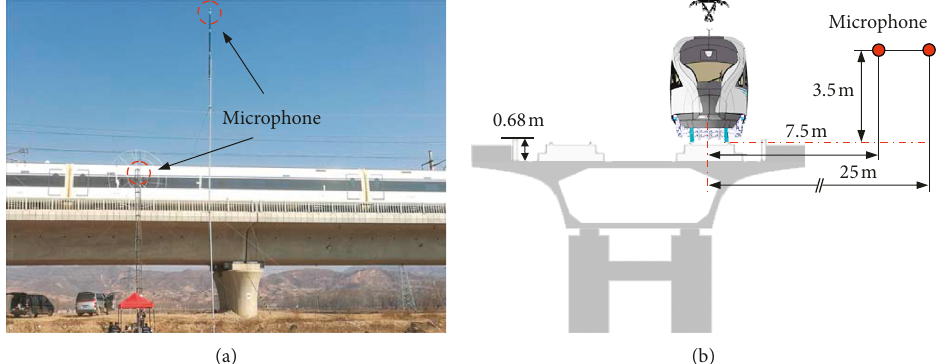
Figure 1: Pass-by noise measurement of a high-speed train. (a) Measurement photograph. (b) Measurement points.